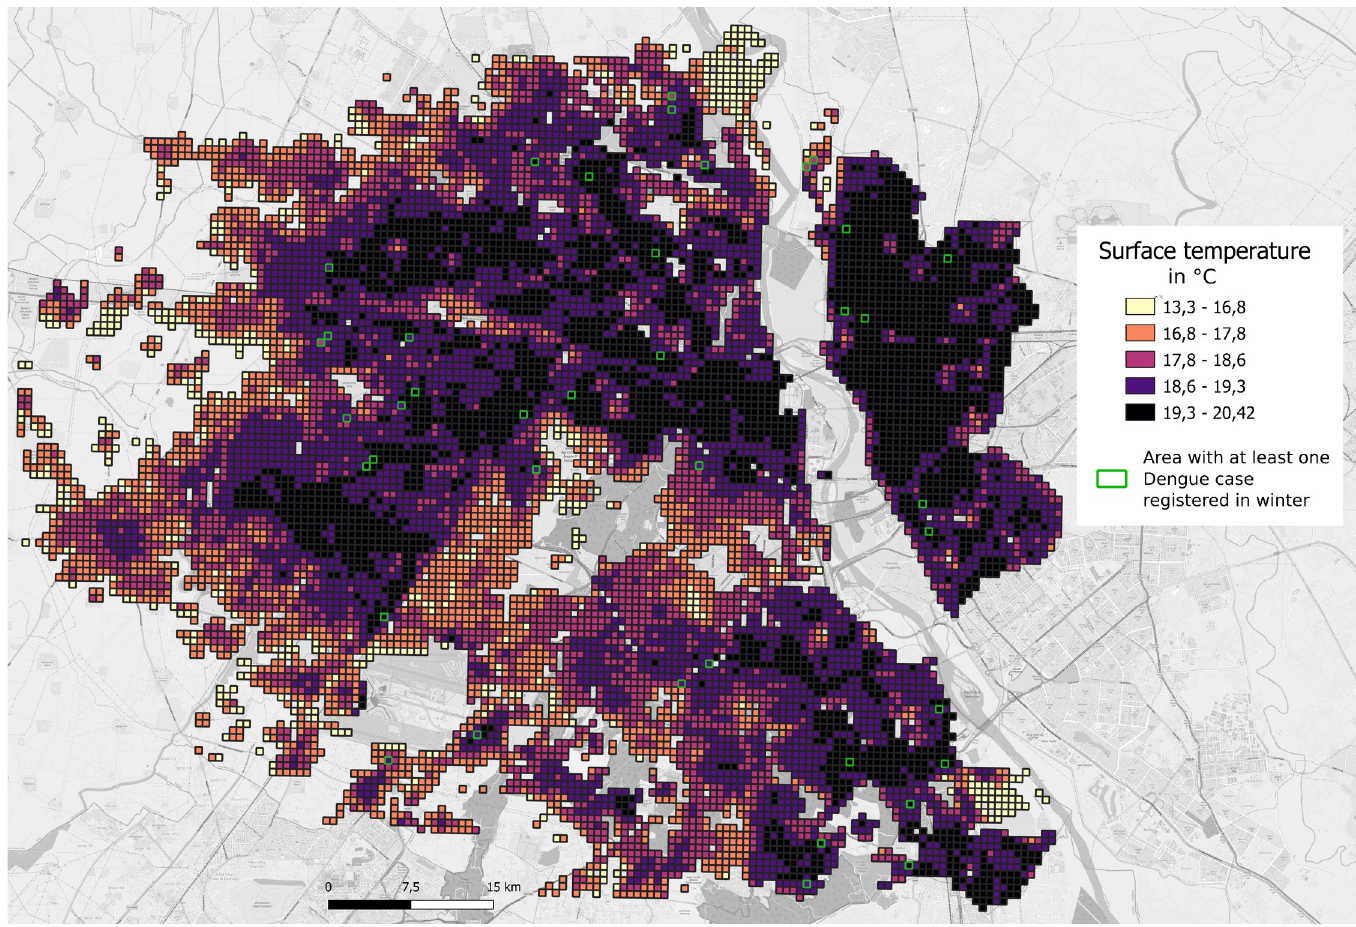
Fig 5. November night-time temperatures and location of the winter dengue cases.